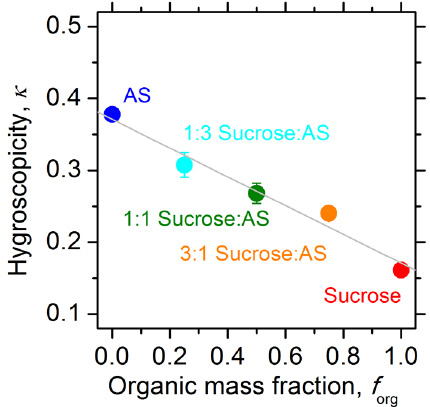
Figure 9. Correlation between the hygroscopicity parameter κ and the organic mass fraction ( f org ) . Indicated component ratios are mass ratios. The solid line is a linear least square fit with an equation of κ = 0 . 37 − 0 . 20 · f org with a correlation coefficient R of